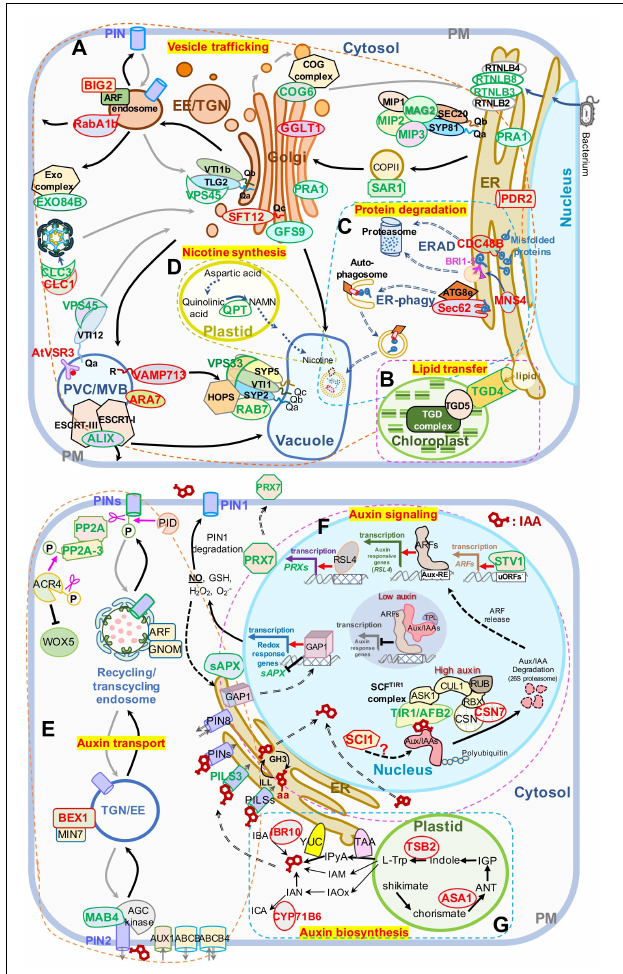
FIGURE 5 | Schematic presentation of DAPs enriched in panel (A–D) vesicle trafficking and (E–G) auxin-related pathways. (A) Intracellular vesicle trafficking pathways. (B) Lipid transfer pathways. (C) Protein degradation pathways including ERAD and ER-phagy. (D) Nicotine biosynthesis pathways. (E) Auxin transport pathways. (F) Auxin signaling pathways. (G) Auxin biosynthesis pathways. Protein names in red and green represent increased and decreased DAP abundances, respectively. The ranges of panel (A–G) are defined by frames with dashed lines. AUX1, auxin resistant 1; ABCA, ATP binding cassette; ANT, anthranilate; AUX/IAAs, auxin/indole-3-acetic acid proteins; ARFs, auxin response factors; Aux-RE, auxin response element; ASK1, Arabidopsis serine/threonine kinase 1; ACR4, Arabidopsis crinkly 4; ATG8e, autophagy 8e; ALIX, ALG-2 interacting protein-X; BEX1/MIN7, bfa-visualized exocytic trafficking defective1/hopm interactor 7; CSN, COP9 signalosome subunit 7; CUL1, cullin 1; CYP71B6, cytochrome p450 71 B6; CDC48B, cell division cycle 48 B; COG6, conserved oligomric Golgi complex 6; CLC1, clathrin light chain 1; CLC3, clathrin light chain 3; EXO84B, exocyst complex component 84 B; EE, early endosomes; ER, endoplasmic reticulum; ERAD, endoplasmic reticulum (ER)-associated degradation; GAP1, GTPase-activating protein 1; GFS9, green fluorescent seed 9; GGLT1, golgi GDP- L -galactose transporter 1; IGP, indole-3-glycerol phosphate; IAOx, indole-3-acetaldoxime; IAM, indole-3-acetamide; IPyA, indole-3-pyruvic acid; ICA, indole-3-carboxaldehyde; IAN, indole-3-acetonitrile; IBA, indole-3-butyric acid; IBR10, indol-3-butyric acid response 10; L -Trp, L -tryptophan; MAB4, macchi-bou 4; MNS4, mannosidase 4; PIN, PIN-FORMED; PRX7, peroxidase 7; PILS3, PIN-LIKES 3; PP2A, protein phosphatase 2A; PID, PINOID; PRA1, prenylated rab acceptor 1; PDR2, phosphate deficiency response 2; QPT,